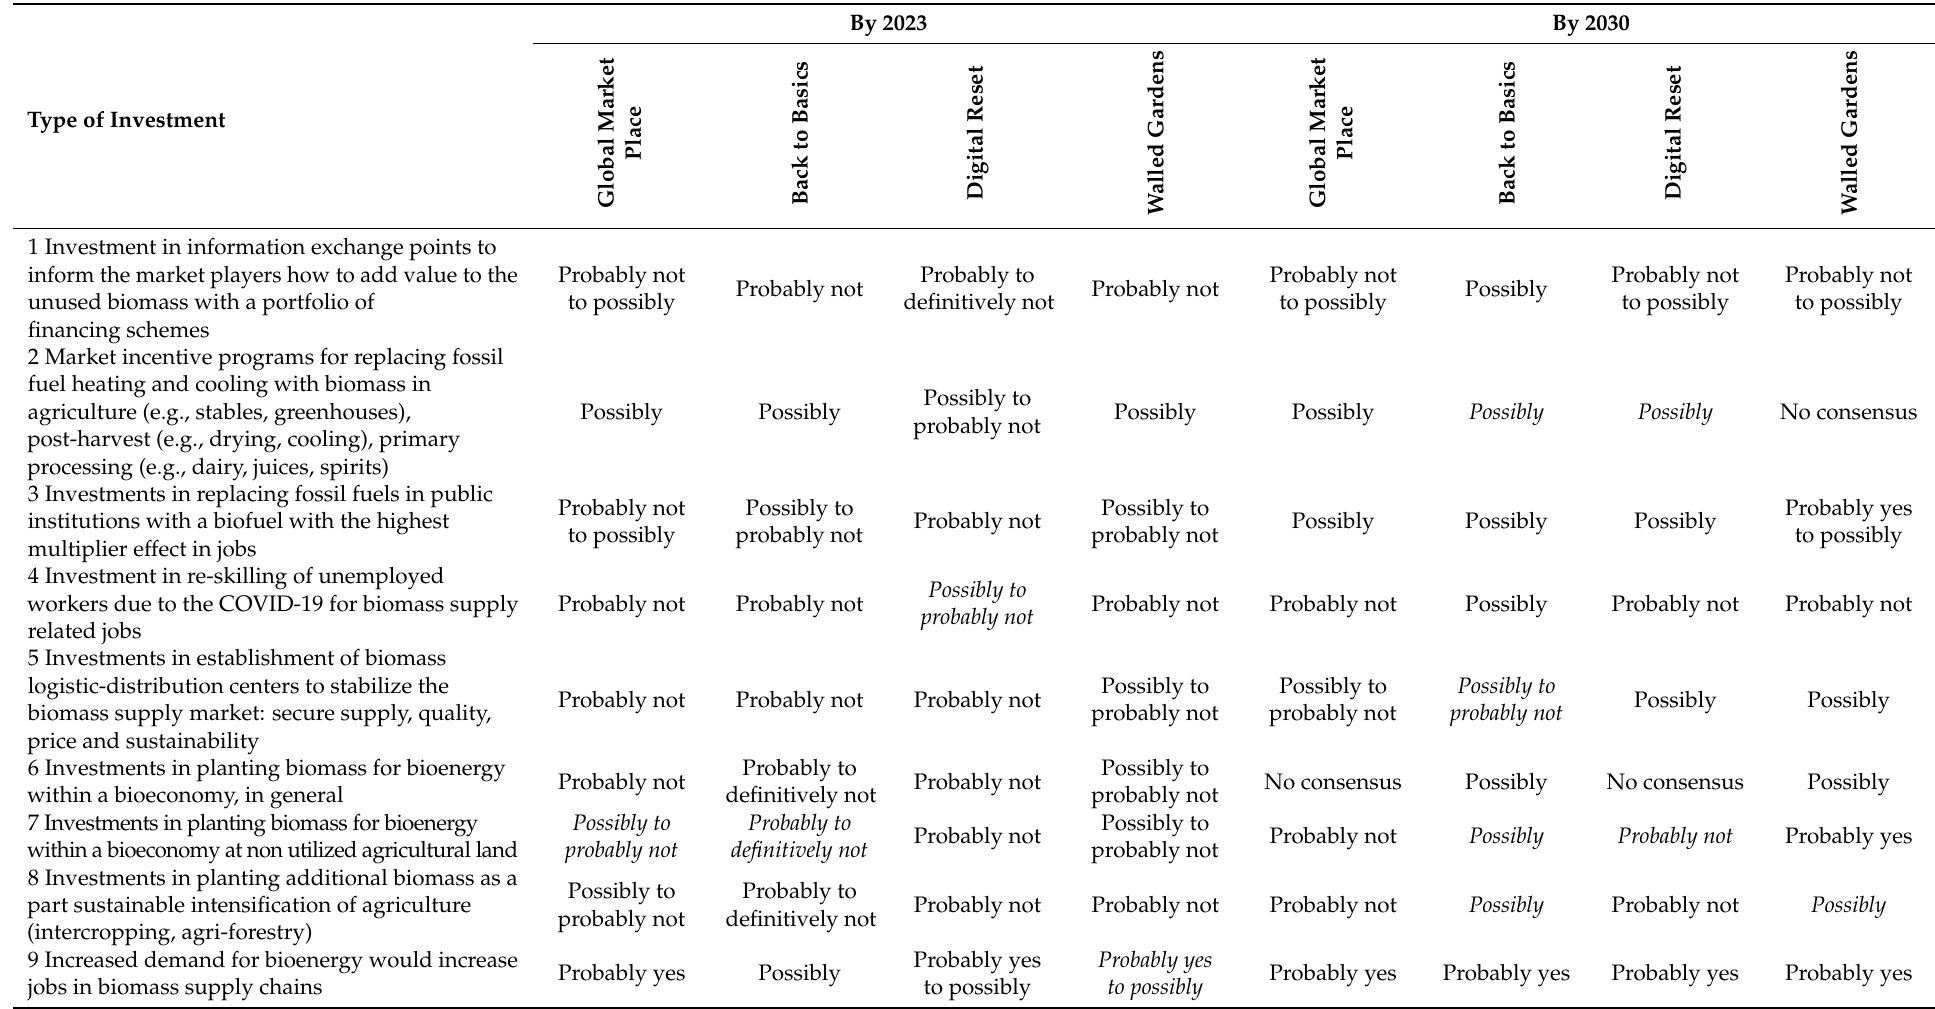
Table A8. Expert consensus on investments related to the biomass supply chains to create jobs under different scenarios and timeframe